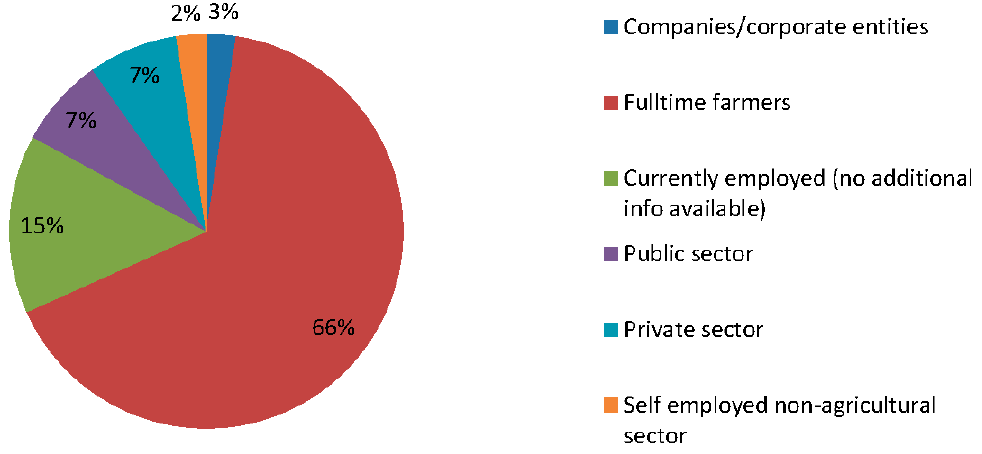
Figure 7. Land acquisitions, 2011–2014 ( N = 300). Source: Authors’ medium-scale farm survey in the Mchinji, Kasungu and Lilongwe Districts undertaken by LUANAR, UP, and MSU (2014–2015). Note: Land acquisitions include lease deals and customary land.